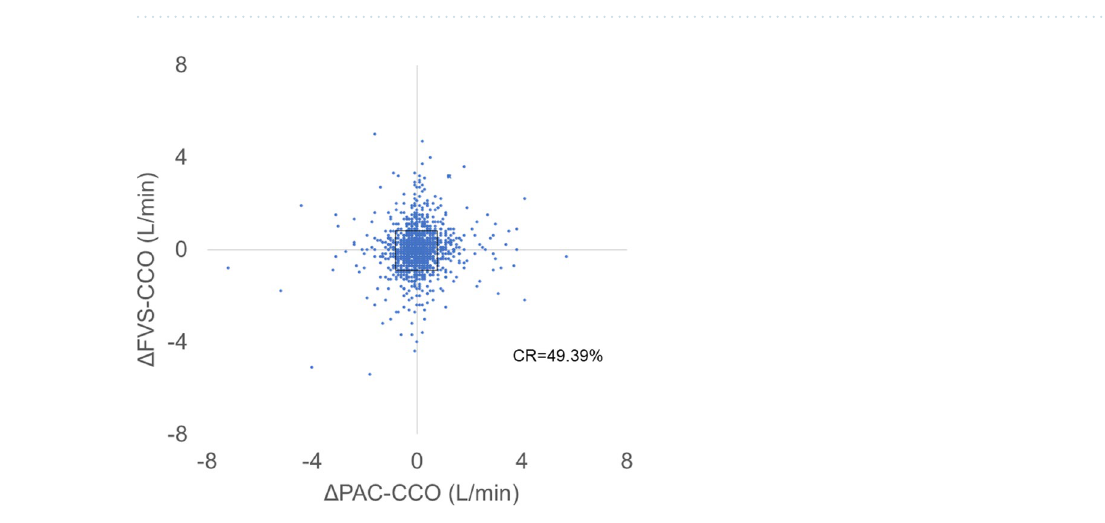
Figure 5. Plots of bias and 95% confidence interval (95% CI) for all data pairs, in data pairs with SVR < 800 and ≥ 800 dyne·s·cm -5 , and in each surgical phase. Bias was close to 0 in cases with SVR ≥ 800 dyne·s·cm -5 and in the dissection phase.